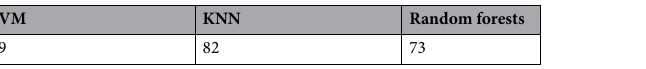
Table 7. Prediction accuracy of VR suitability in sports training from the VR suitability predictor by 3D-multiple object trucking in each algorithm.